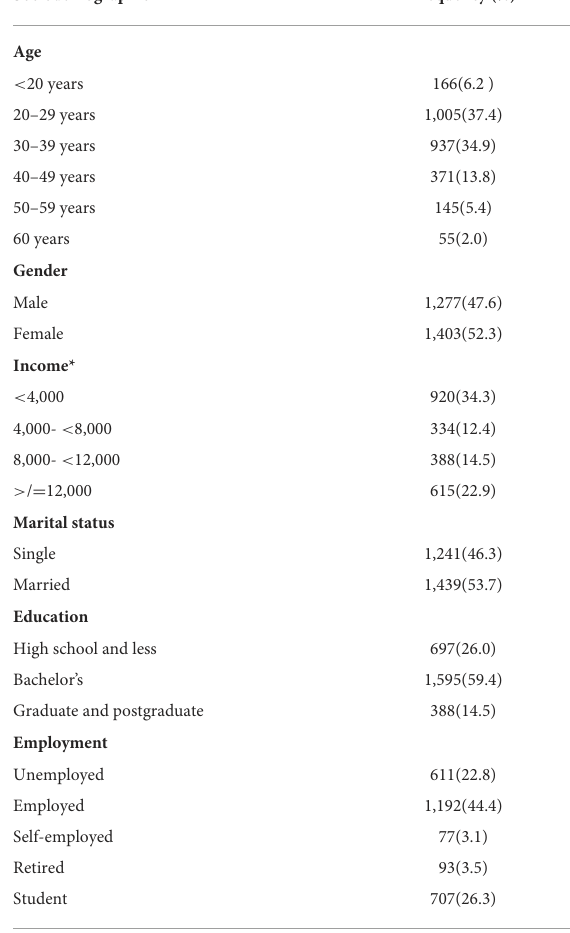
TABLE 1 Sociodemographic characteristics of study participants ( N =